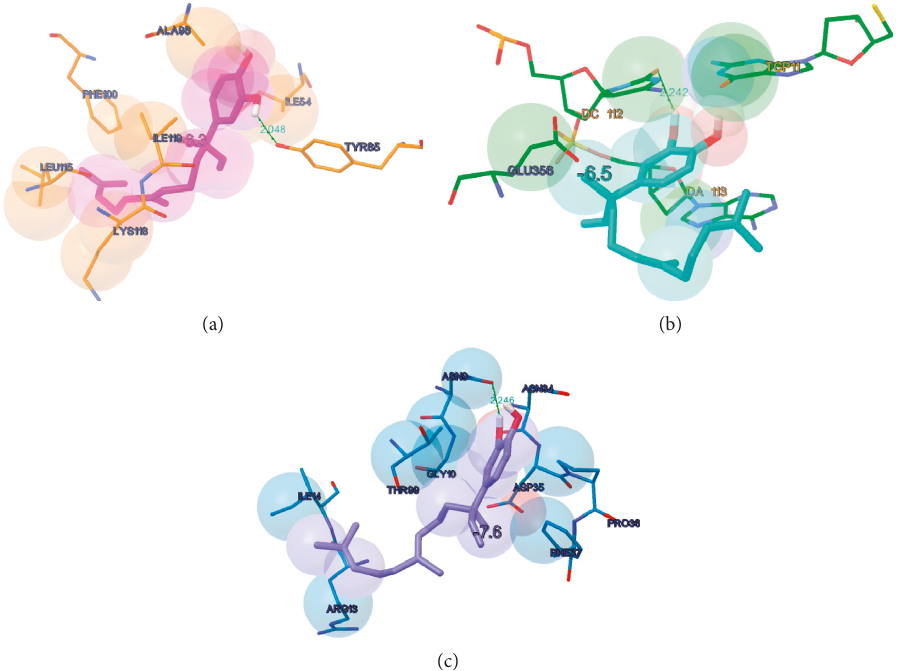
Figure 9: Binding modes of the 4NRC docked to PfLDH (a), TOPO I (b), and GAPDH (c). Green lines indicate hydrogen bonds.